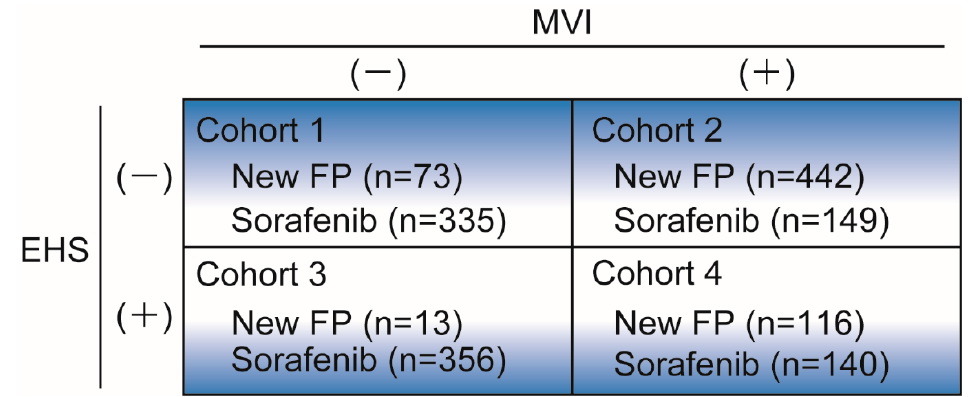
Figure 1. Subgroup analyses.